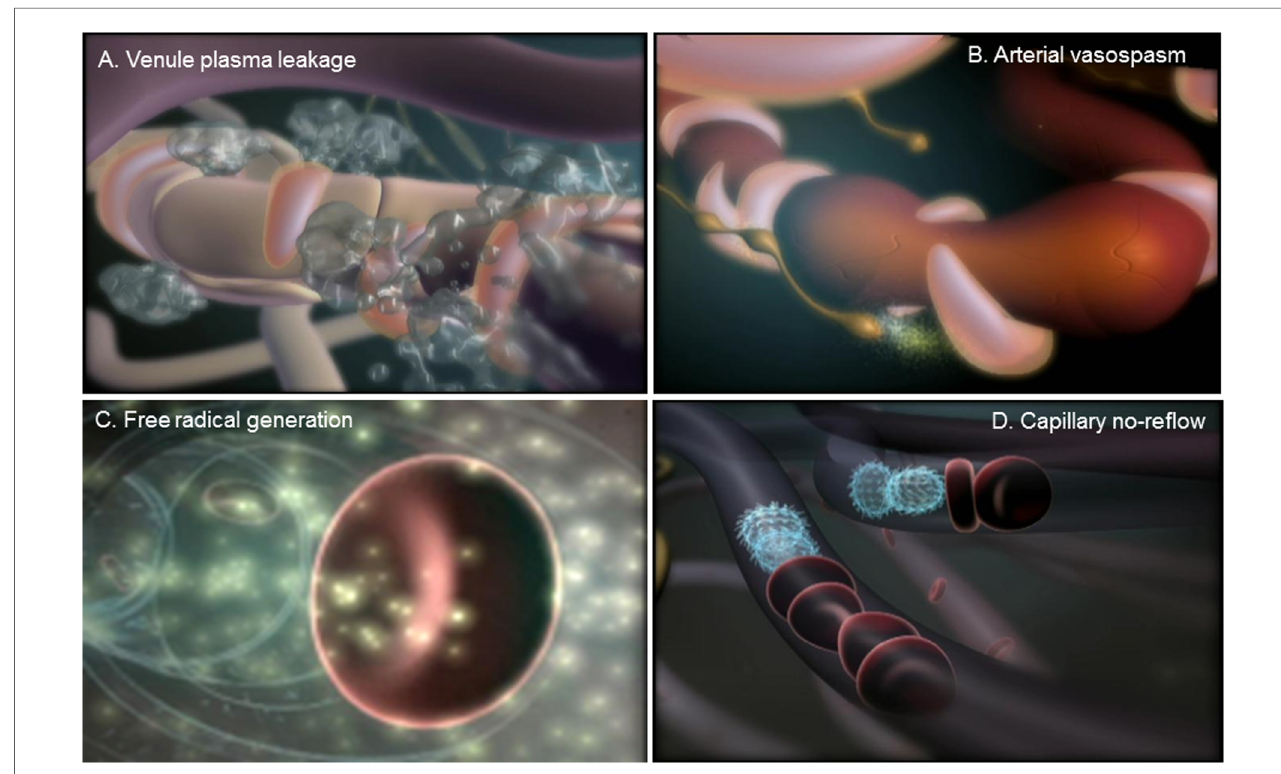
FIGURE 1 Microvascular response to tissue injury. ( A ) Swelling or edema is caused by a leakage of plasma proteins from microvessels within the post-capillary venules. ( B ) Extensive edema within damaged tissue can cause vasospasms within arterioles that can produce prolonged tissue ischemia. ( C ) Reperfusion of microvessels in the ischemic tissue generates the production of oxygen and nitrogen free radicals, which produce injury of the endothelial lining, attraction and adhesion of platelets and leukocytes, activation of the coagulation cascade, and increased thrombosis. ( D ) The adhesion of platelets and leukocytes leads to a blockade of blood fl ow within capillaries, or the phenomenon capillary no-re fl ow, which encourages arteriovenous shunting and the enhanced proliferation of blood and lymphatic